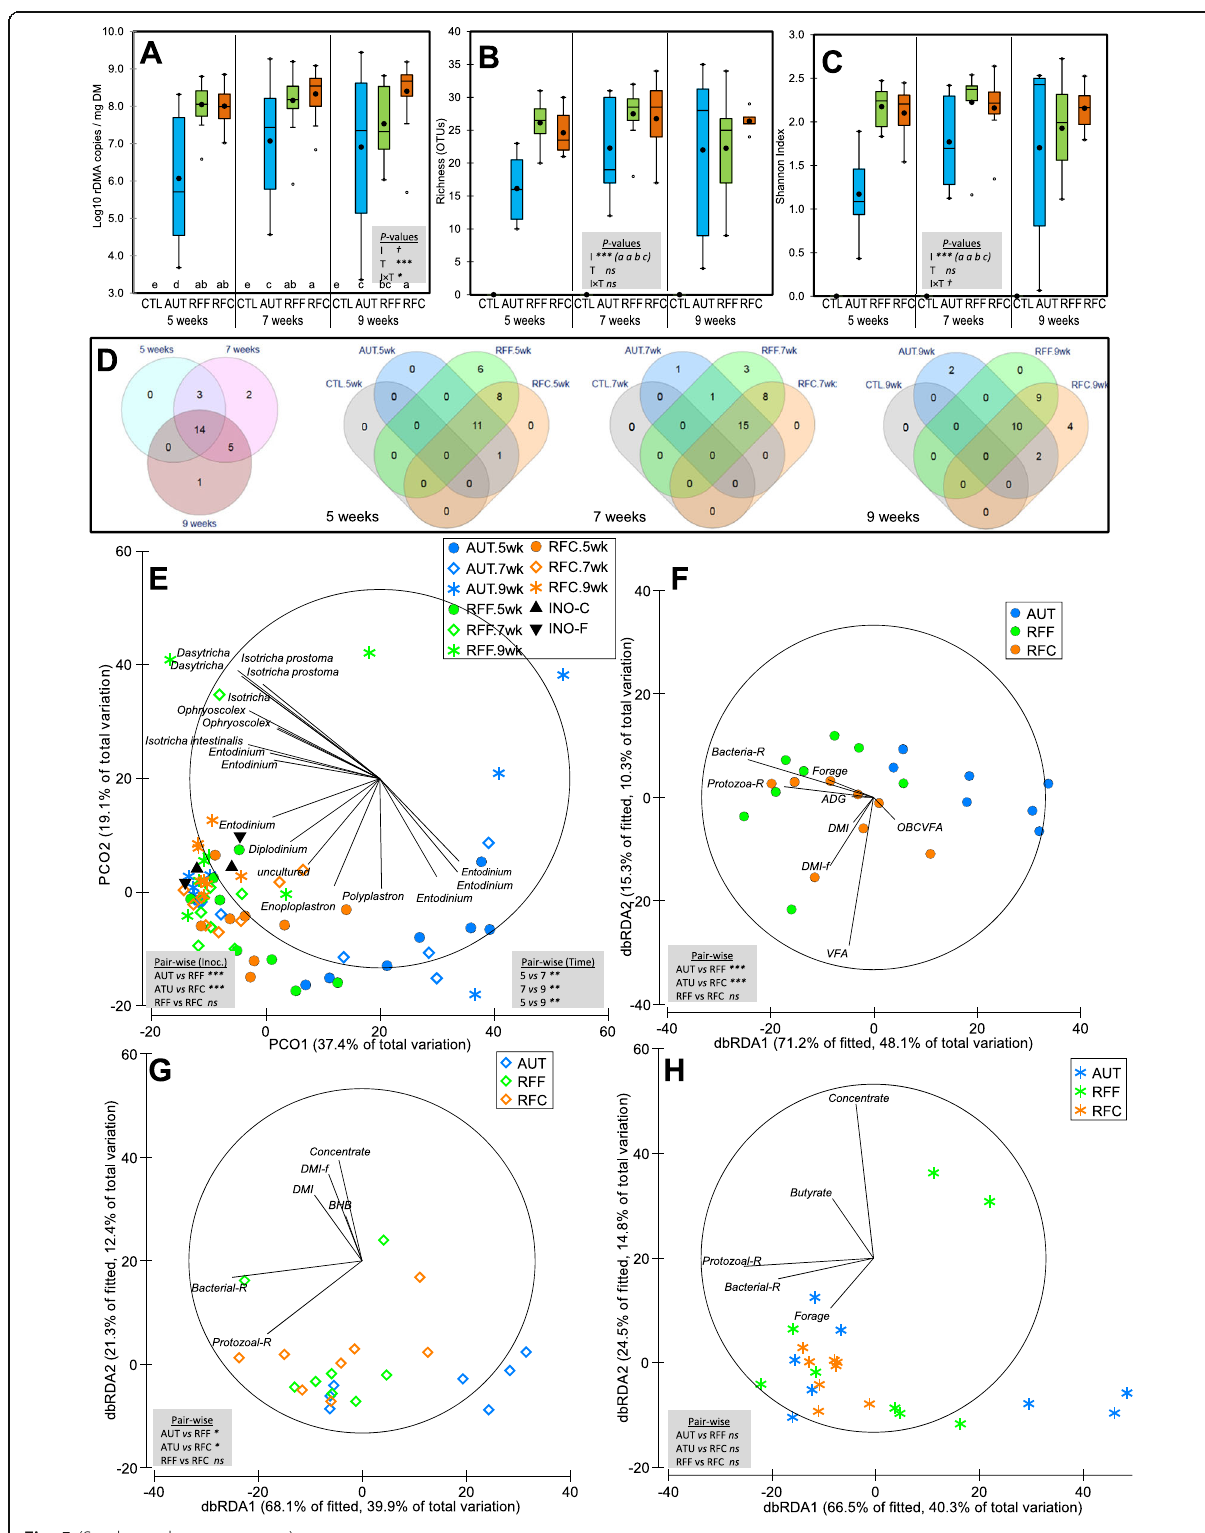
Fig. 5 (See legend on next